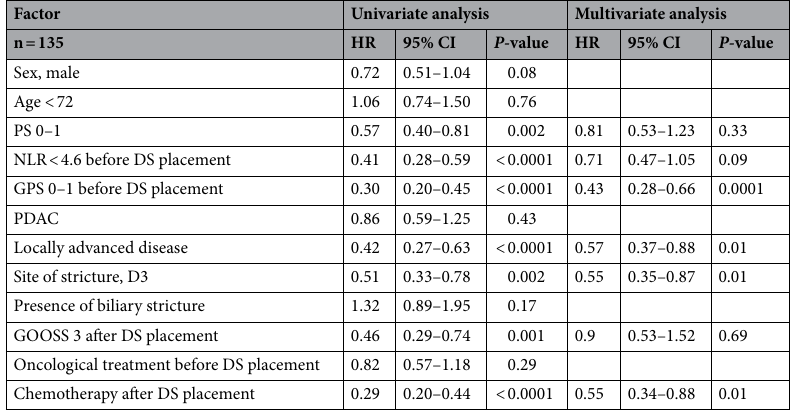
Table 6. Univariate and multivariate analyses for overall survival after DS placement. CI confidence interval, DS duodenal stent, GOOSS Gastric Outlet Obstruction Scoring System, GPS Glasgow Prognostic Score, HR hazard ratio, NLR neutrophil-to-lymphocyte ratio, PDAC pancreatic ductal adenocarcinoma, PS performance status.